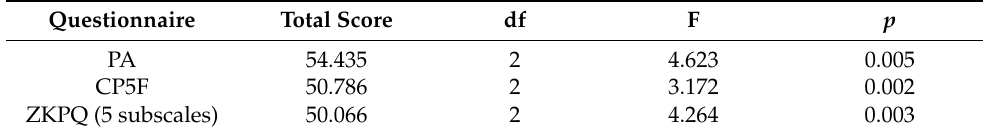
Table 10. ANOVA—analysis of variance between the three study groups. Questionnaire Total Questionnaire